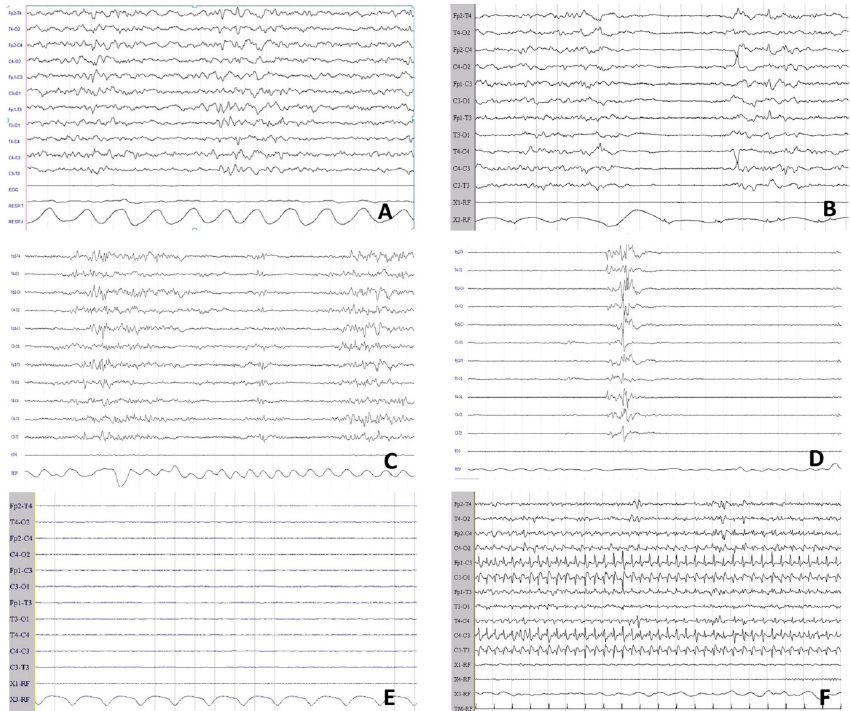
Figure 1. Classification of p-EEG abnormalities adapted with permission from Murray et al. [14]. p-EEG recording of patients included in the study are used as examples. ( A ): grade 0 (normal p-EEG). ( B ): grade 1 (normal/mild abnormalities). ( C ): grade 2 (moderate abnormalities). ( D ): grade 3 (severe abnormalities). ( E ): grade 4 (inactive p-EEG). ( F ): EEG confirmed seizure.